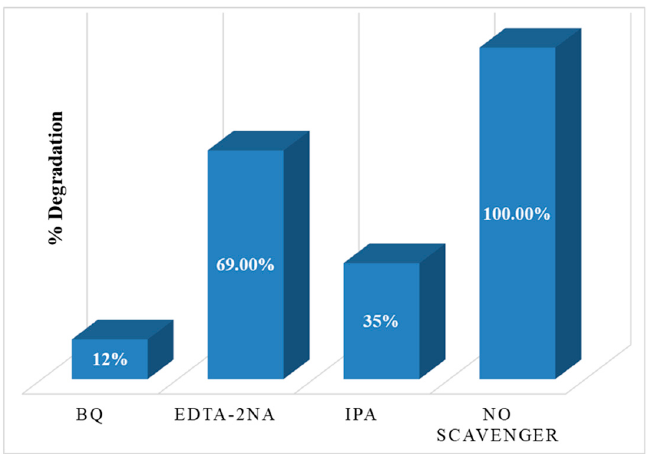
Figure 8. Effect of radical scavengers in the catalytic degradation of MB with Co-SnO 2 /50% SGCN.